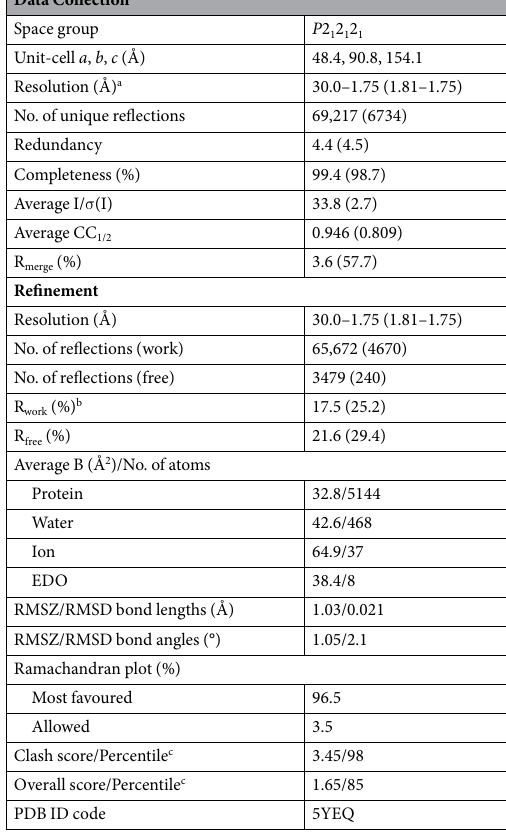
Table 1. Data collection and refinement statistics for Sac-KARI. a The values in parentheses show the statistics for the highest-resolution shells. b R work = ( Σ hkl ||F o | − |F c ||)/ Σ hkl |F o |. R free was calculated with 2.9% of the data excluded from refinement. c Calculated by